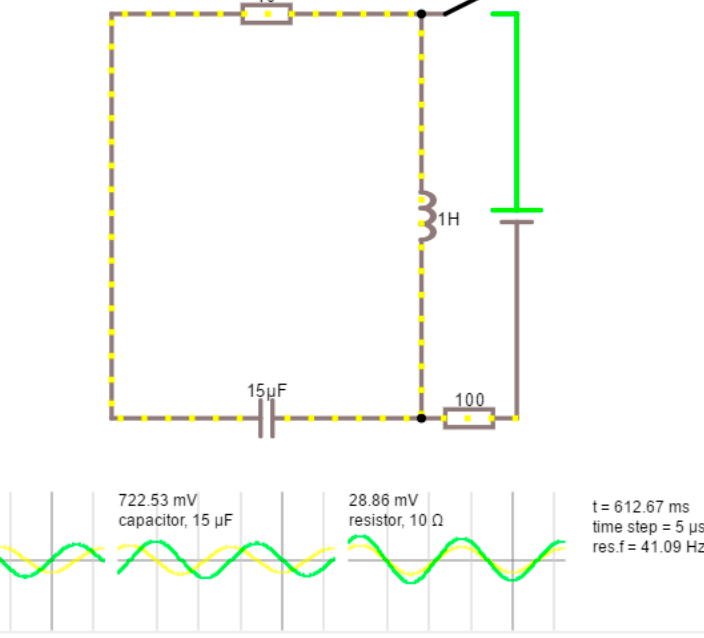
Figure 7. Half wave rectifier simulation.